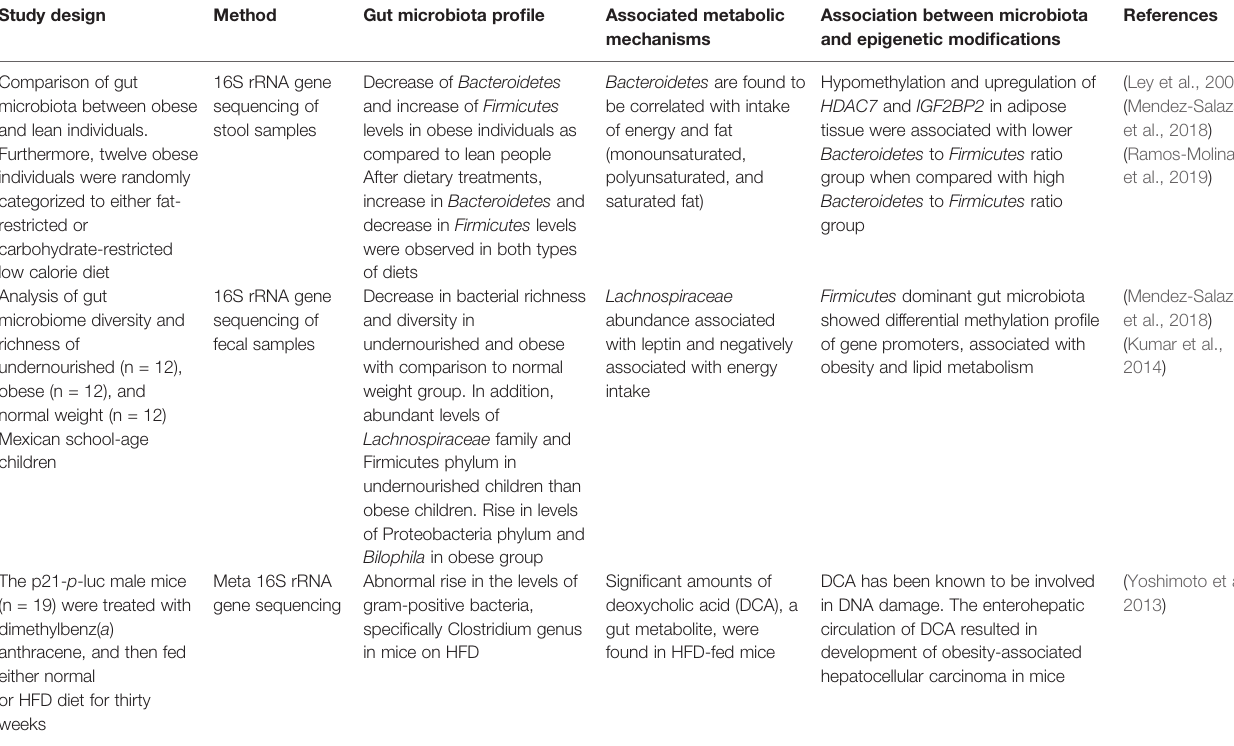
TABLE 1 | The alterations in gut microbiota in obesity and its role in metabolic mechanisms and